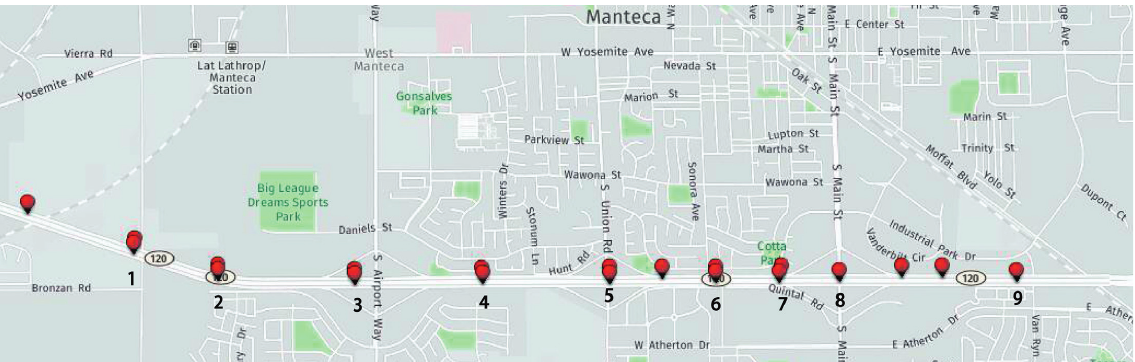
Figure 1: Route of driving data collection.